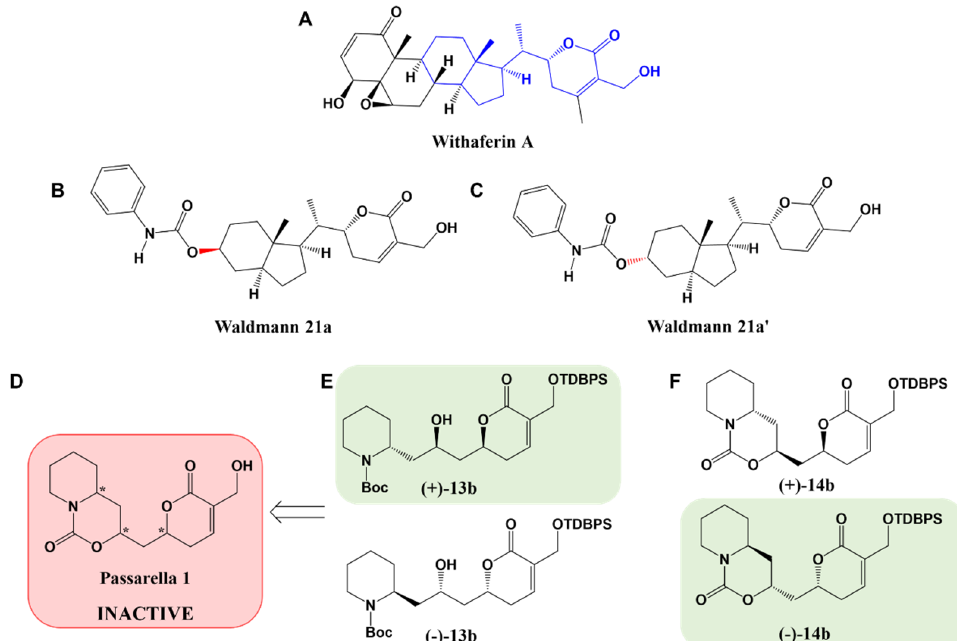
Figure 4. Chemical structures of withaferin A derivatives, novel SMO inhibitors that structurally deviate from Vismodegib. ( A ) Chemical structure of natural product withaferin A. The highlighted scaffold is believed to be important for SMO binding. ( B , C ) The Waldman group developed deriva- tives of withaferin A that exhibited stereoselective potent inhibition of SMO. ( D ) The target compound of the Passarella group for SMO inhibition did not inhibit the Hh pathway. * represent asymmetric carbons. ( E , F ) Synthetic intermediates 13b and 14b exhibited stereoselective inhibition of SMO, elucidating important polarity considerations for protein